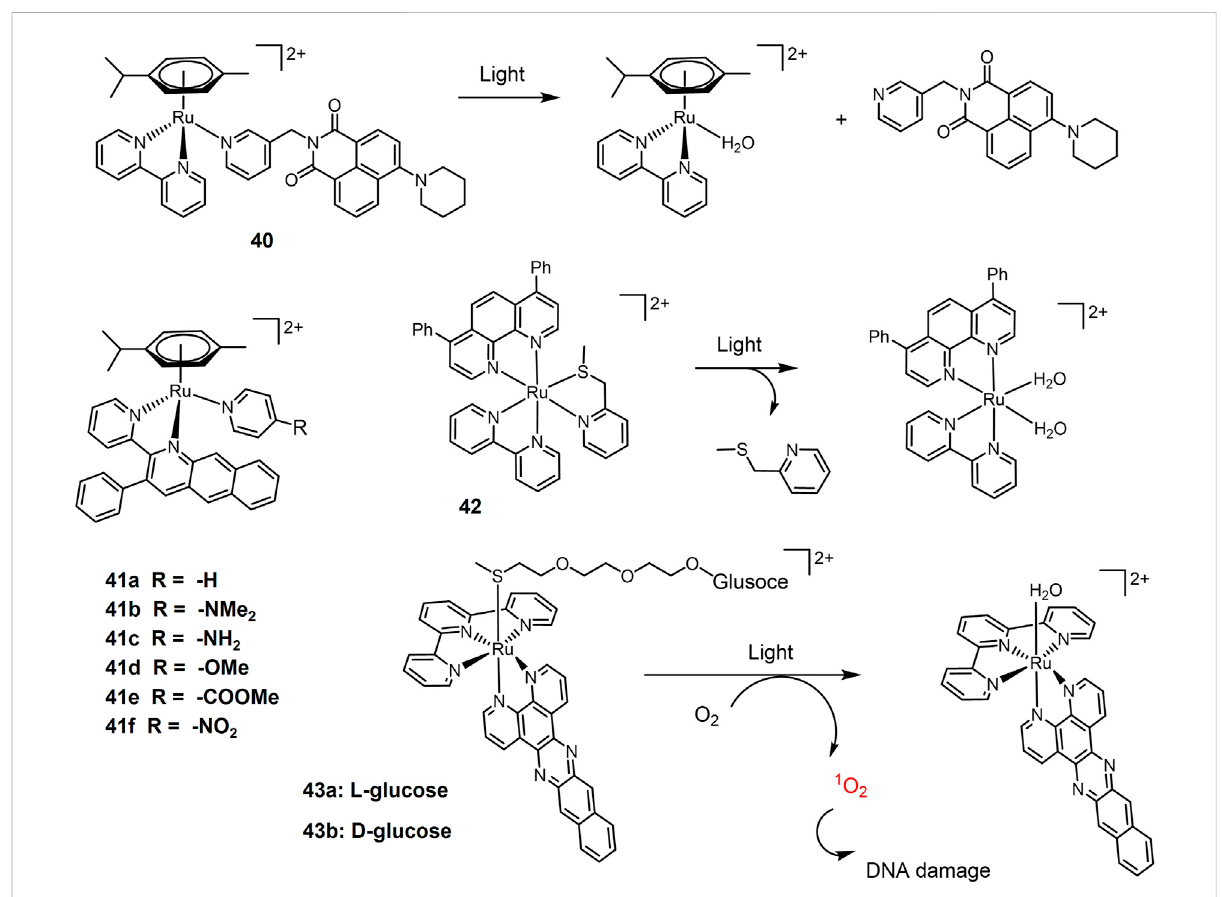
FIGURE 10 Photosubstituting Ru(II) prodrugs for